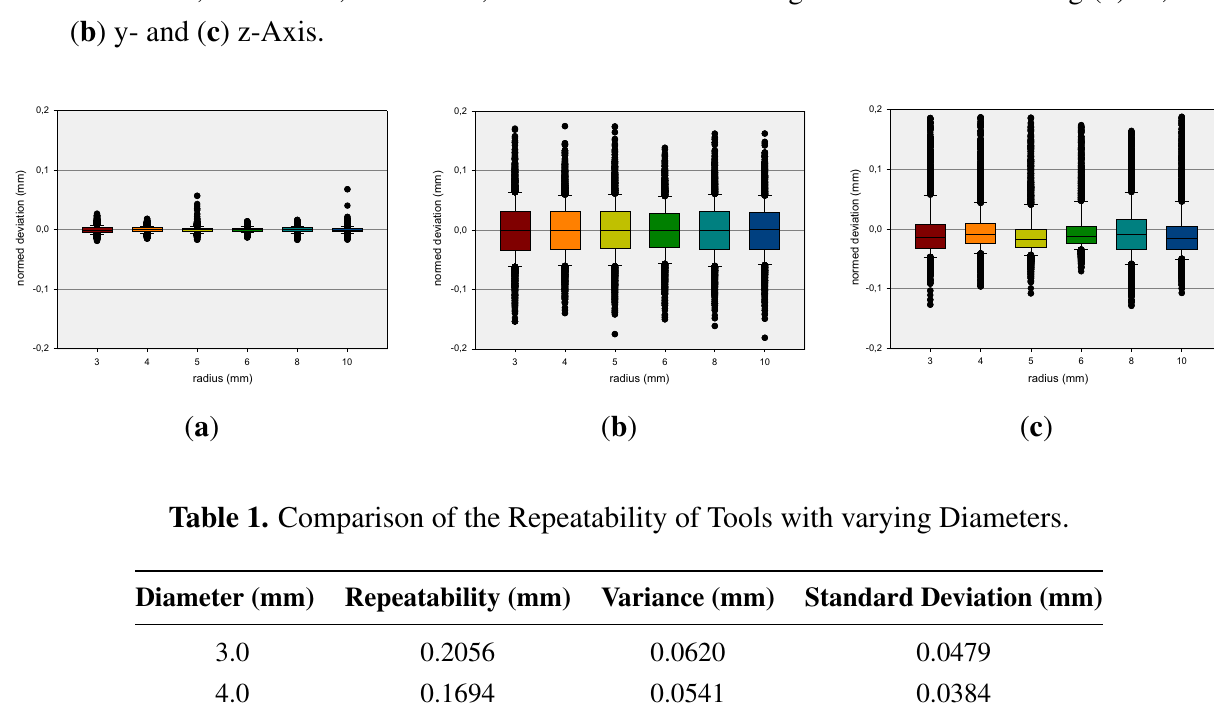
Figure 5. Box-and-whisker Plots for different Tool Diameters: d = 3 mm , d = 4 mm , d = 5 mm , d = 6 mm , d = 8 mm , d = 10 mm of the average Deviation concerning ( a ) x-; ( b ) y- and ( c ) z-Axis.